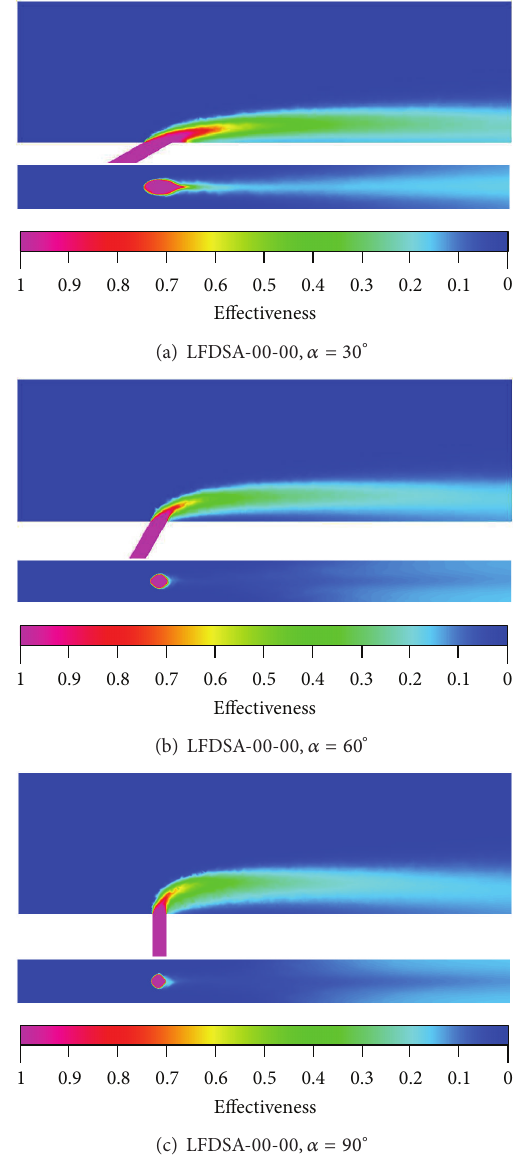
Figure 27: Top and symmetric planes effectiveness of LFDSA-00-00 for different streamwise angles and 𝑀 = 2